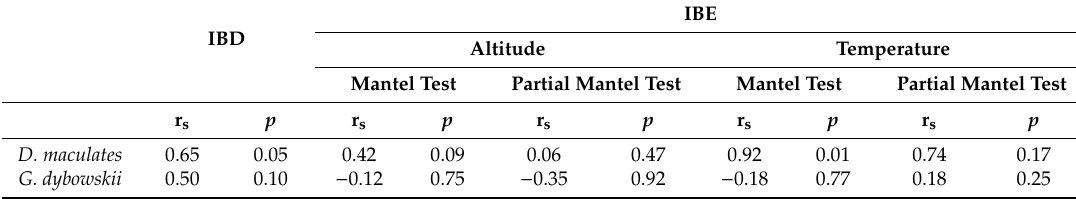
Table 3. Isolation-by-distance (IBD) and isolation-by-environment (IBE) tests with SNP data for two Scizothoracins. IBE IBD Altitude Temperature Mantel Test Partial Mantel Test Mantel Test Partial Mantel Test r s D. maculates